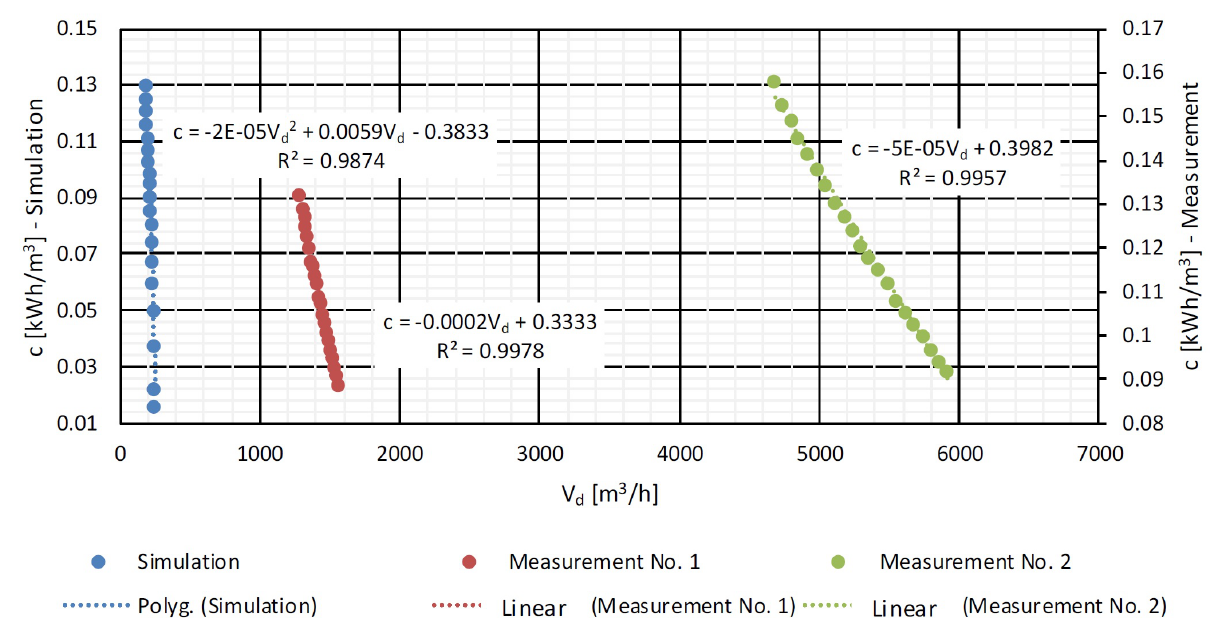
Figure B4: Specific energy consumption